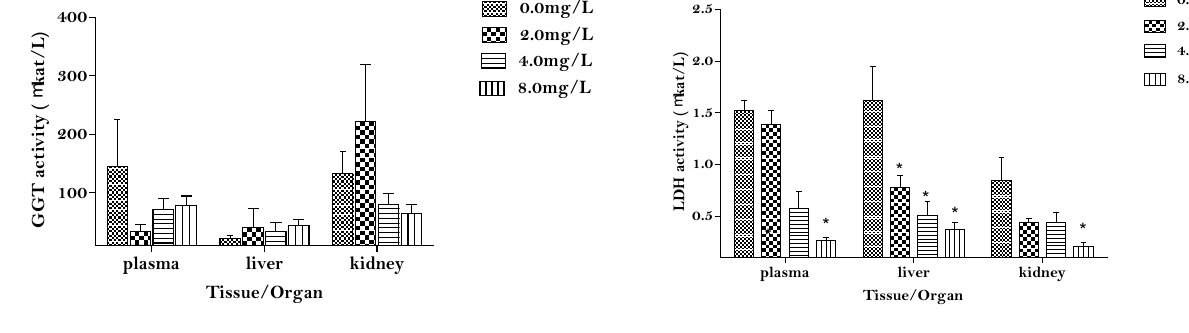
Fig. 2. Gamma glutamyltransferase activity in Clarias gariepinus exposed to sublethal concentrations of chromium after 7days ex- posure period. Symbol as presented in Fig. 1